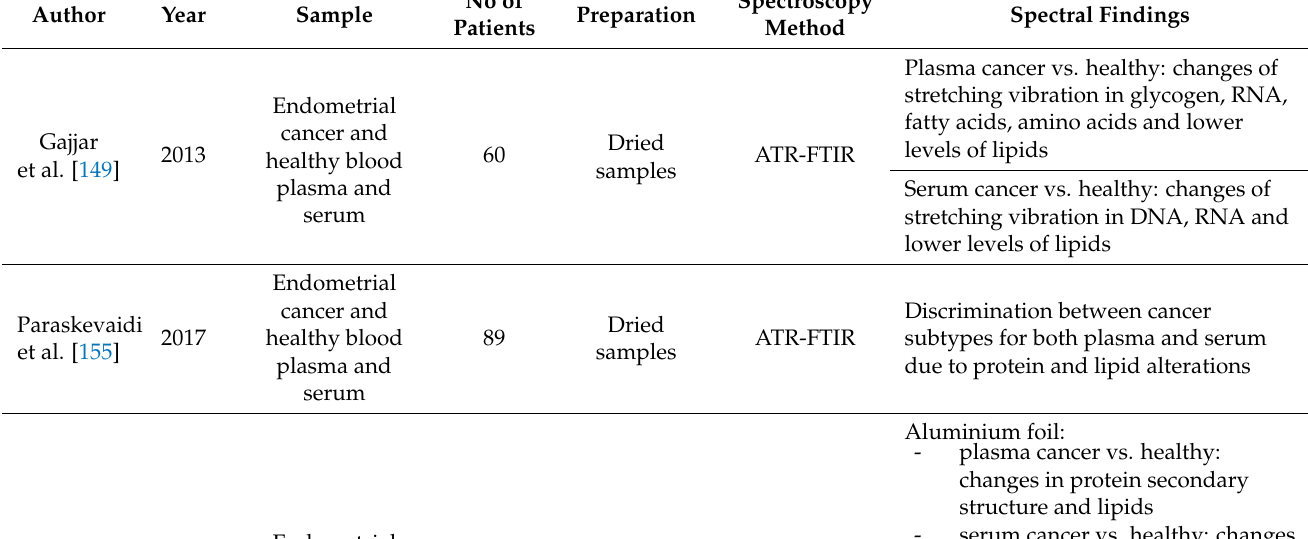
Table 4. Spectroscopy of biofluids: endometrial cancer studies included in this